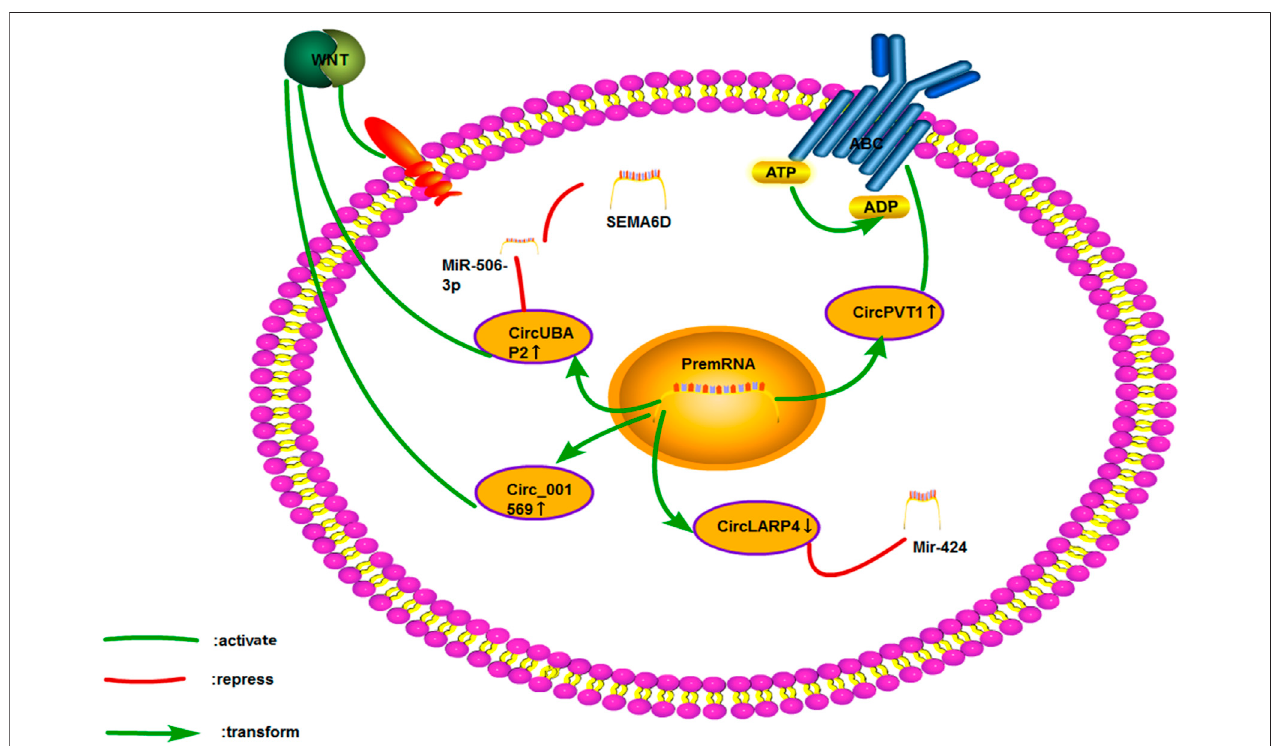
FIGURE 13 | Cisplatin resistance mechanism of circRNA in osteosarcoma. Only four papers have been published on the cisplatin resistance of circRNA in osteosarcoma, which involves ceRNA NET, Wnt signaling pathway, and ABC transporter.